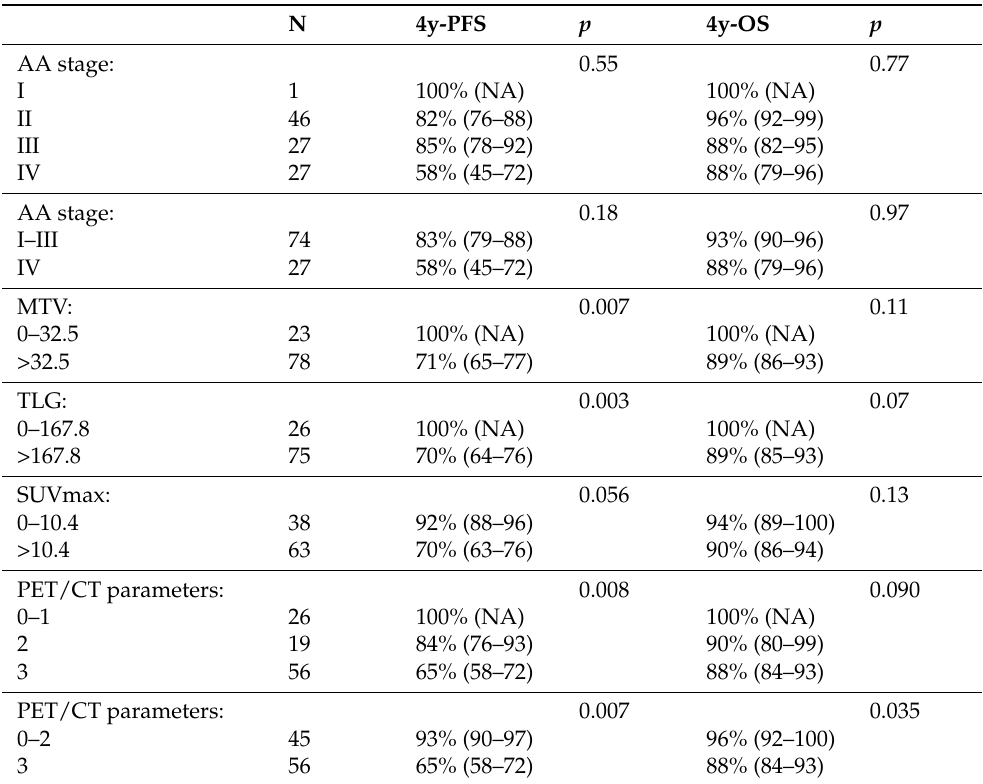
Table 4. PFS and OS according to tumoral load